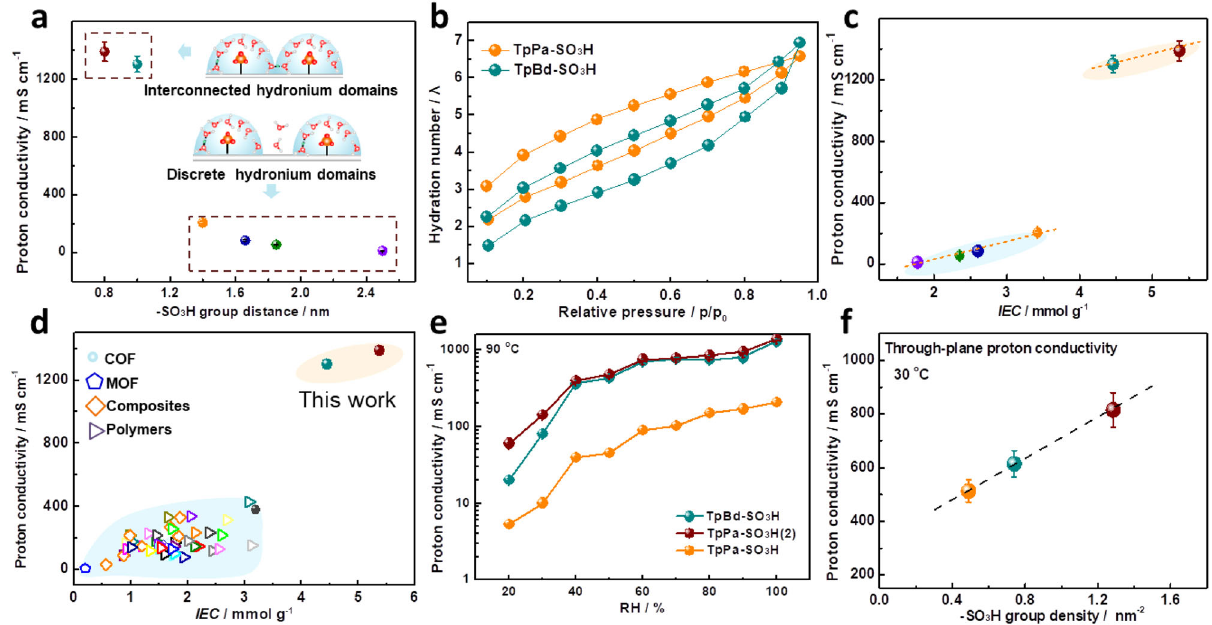
Fig.3|In-planeandthrough-protonconductivityoftheiCOFMs.a -SO 3 Hgroup distance dependent proton conductivity of the iCOFMs at 90°C under 100% RH (inset is the scheme of the in-plane proton transfer on iCOFMs). b Relative humidity-dependent hydration number of the TpPa-SO 3 H and TpBd-SO 3 H mem- branesat30°C. c IECvaluedependentprotonconductivityof theiCOFMsat90°C under 100% RH. d The comparison of the IEC value and proton conductivity